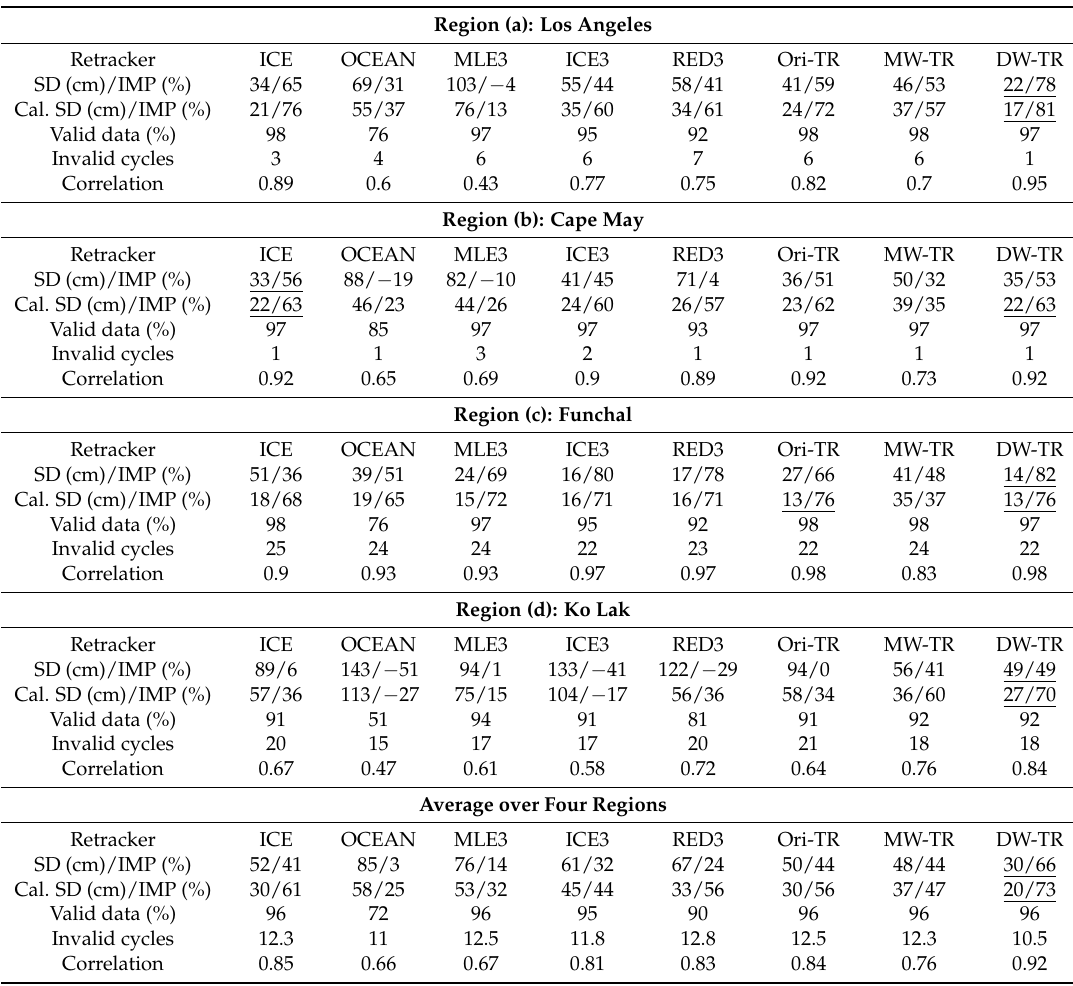
Table 4. Statistics of various retracked SSHs within 10 km offshore compared with tide gauge in each